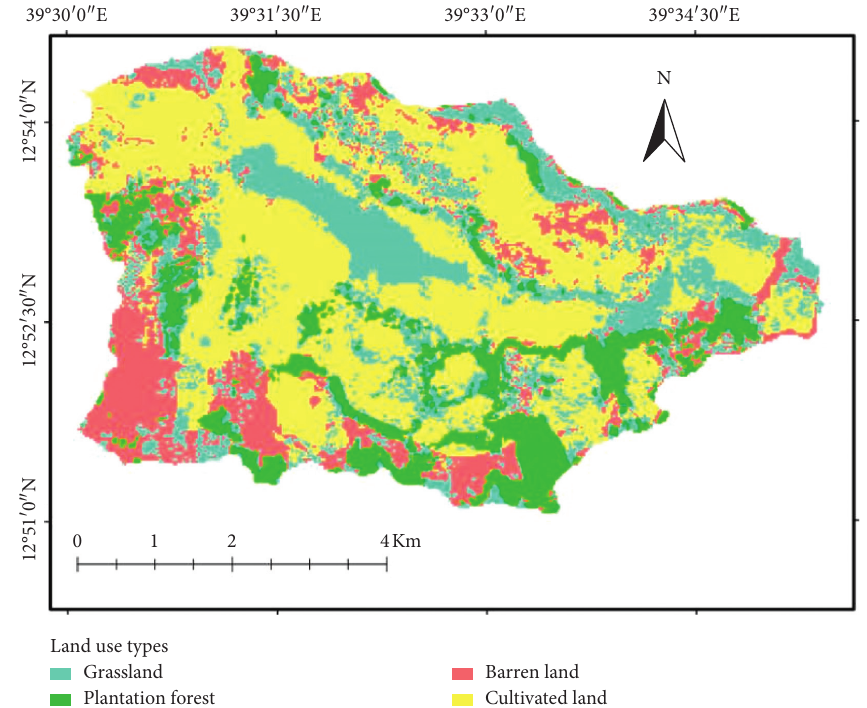
Figure 3: Land use map of the study watershed for the year 2017.